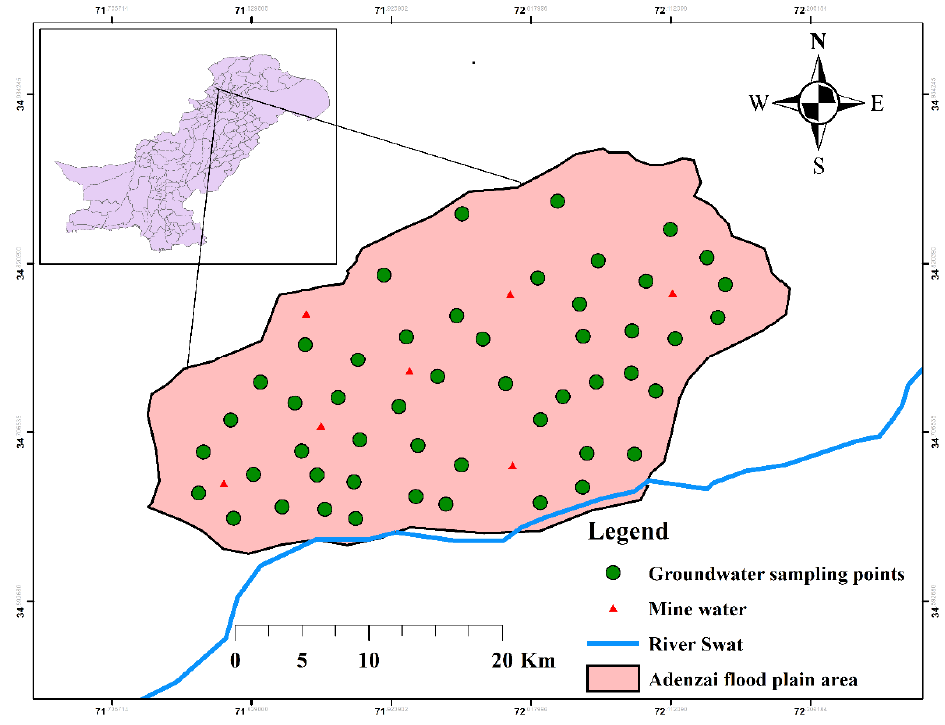
Figure 1. Representation of the location map outline groundwater sampling points in the study area.